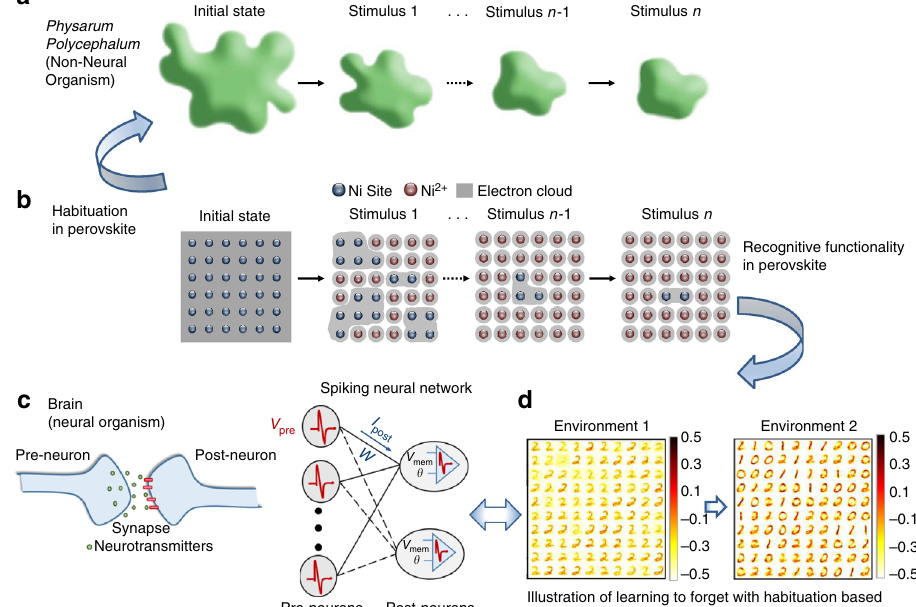
Fig. 1 Quantum material showing habituation behavior observed in neural and non-neural organisms. a Nonassociative habituation learning observed in Physarum polycephalum . When exposed to stimulus, a diminished response is observed indicative of habituation. b Schematic showing the habituation process in a perovskite SmNiO 3 ( SNO ). Between repeated stimuli (H 2 ), the dynamics of carrier localization subsides, showing both non-neural habituation and neural synaptic plasticity. c Associative spike-timing based learning observed in a biological neural system (brain) responsible for memory formation. In the brain, synaptic plasticity is modulated by chemical transmitters, and is a function of the relative timing difference between the post and pre-neuronal spikes. The biological neural system is implemented as a Spiking Neural Network ( SNN ) that consists of a fully connected array of pre-neurons and post-neurons. The pre-neuronal voltage spike ( V pre ) is modulated by the synaptic weight ( w ) to generate the resulting post-synaptic current ( I post ). The post-neuron integrates the current that results in an increase in its membrane potential ( V mem ) and spikes when the potential exceeds a certain threshold ( θ ). d In environment 1, the SNN was presented with different images of digit 2 and learnt several patterns corresponding to the given image. In environment 2, the SNN was presented with images of digits 0 and 1. Incorporating habituation-based nonassociative learning with standard associative spike-timing dependent plasticity ( STDP ) enables the SNN to learn new patterns without catastrophic forgetting in a resource-constrained dynamic input environment. The color intensity of the patterns are representative of the value of synaptic weights with lowest intensity ( white ) corresponding to a weight value of − 0.5 and highest intensity ( black ) corresponding to